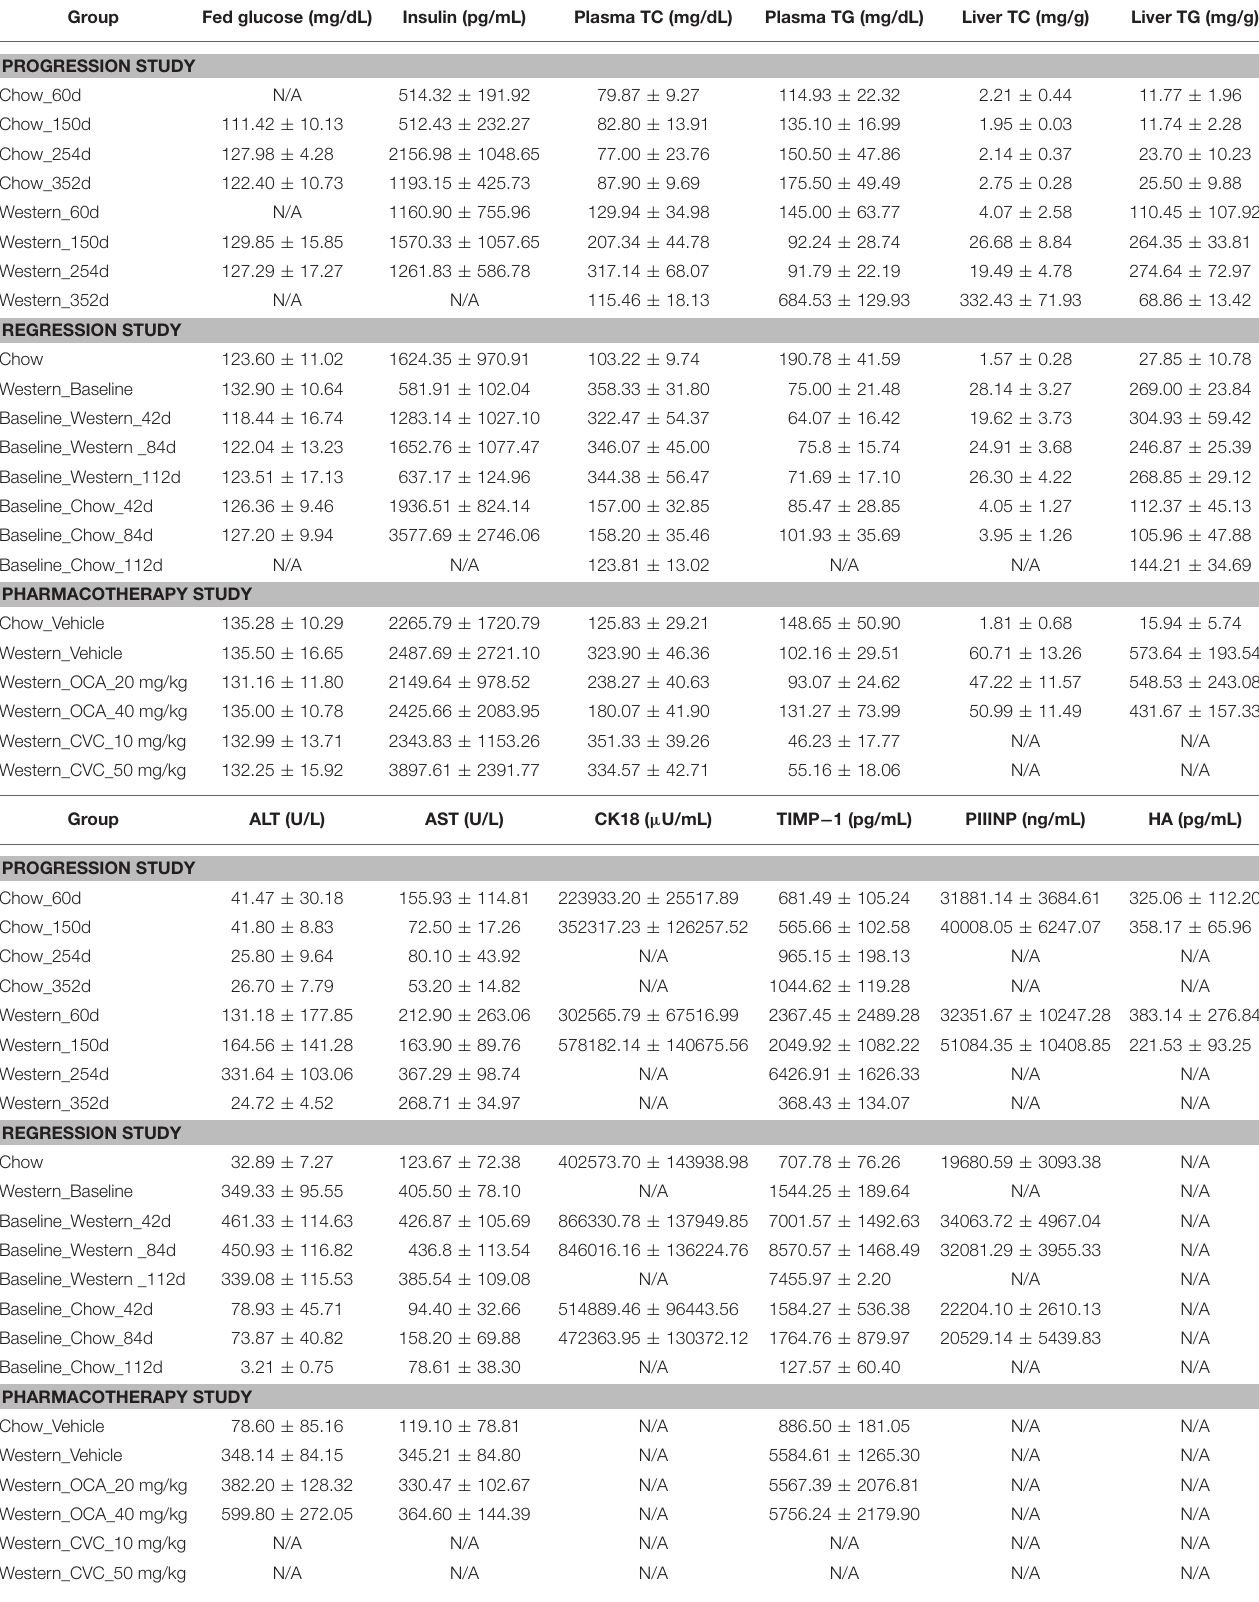
TABLE 2 | Biochemical analysis of blood and liver samples (Average ± SD).